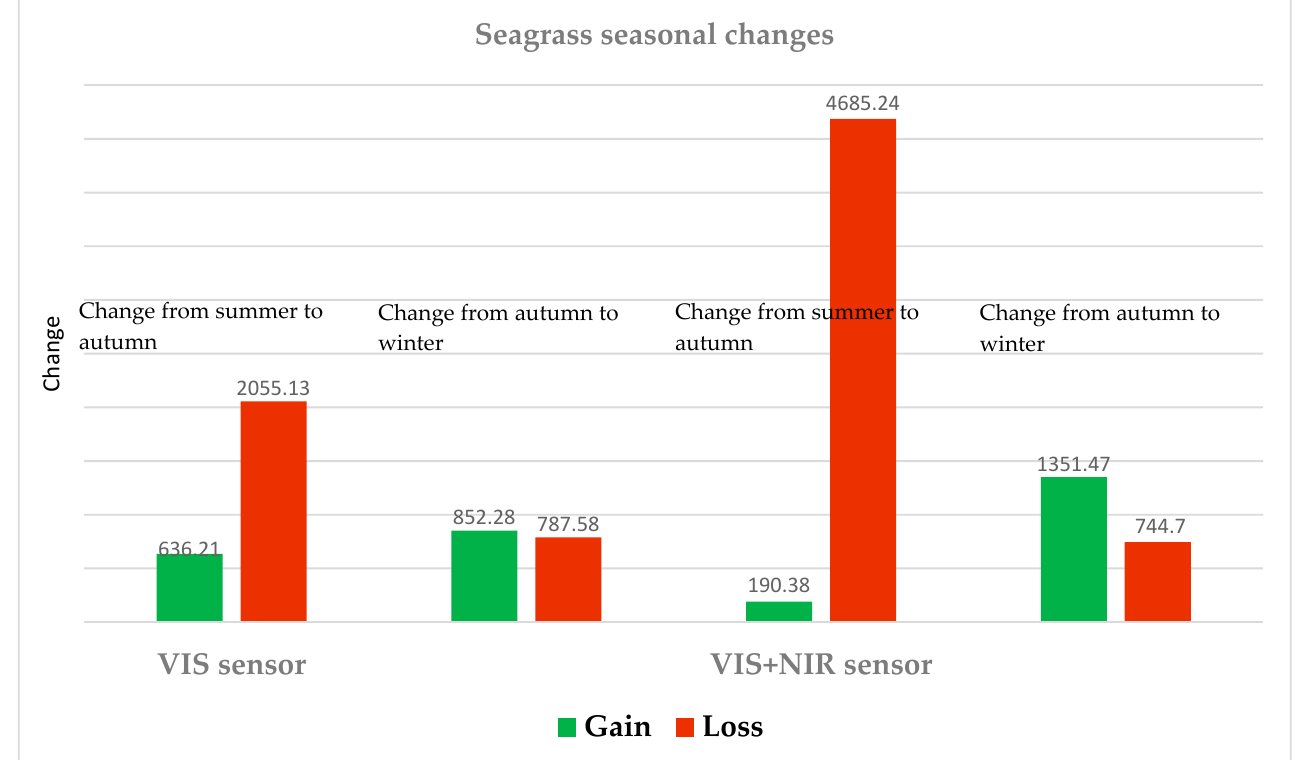
Figure 8. Graph of time-series density seasonal change in seagrass meadows using VIS and VIS+NIR orthomosaic from summer to autumn and autumn to winter.